Question: According to this chart, does the measure grow or shrink?
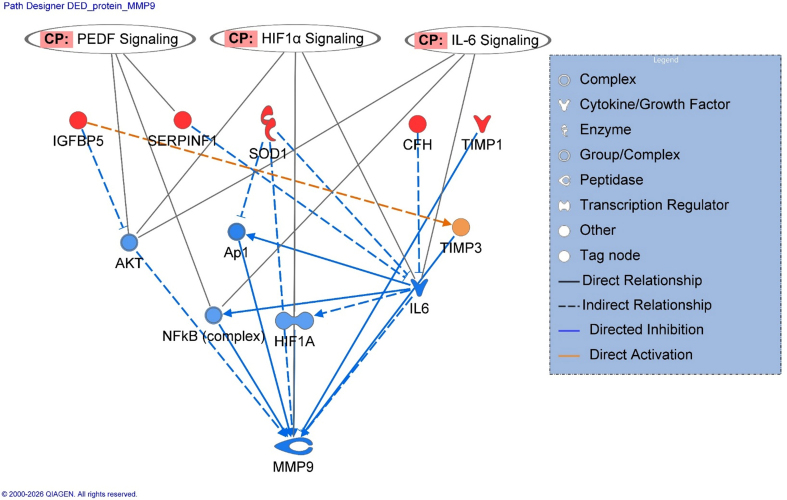
Answer: increasing